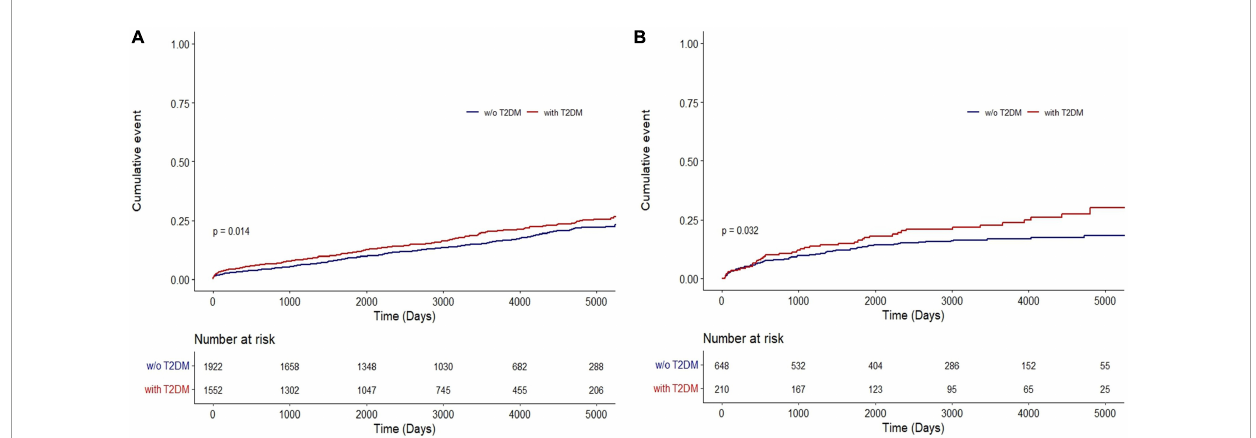
FIGURE2 Cumulative incidence of lung cancer in COPD patients with and without T2DM in (A) the NHIS-NSC and (B) the CDM cohort. CDM, common data model; NHIS-NSC, national sample cohort of National Health Insurance Service; T2DM, type 2 diabetes mellitus; w/o, without.